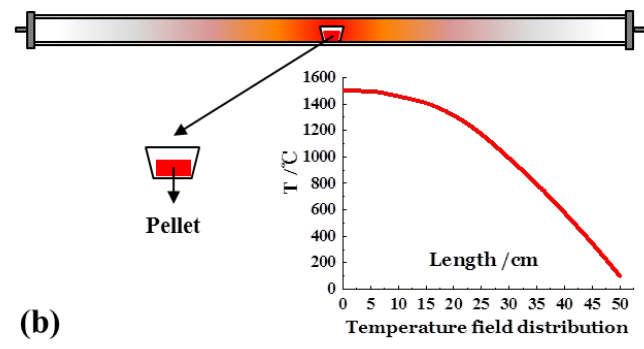
Figure 1. ( a ) Schematic of the experimental apparatus and ( b ) temperature profile of the furnace.